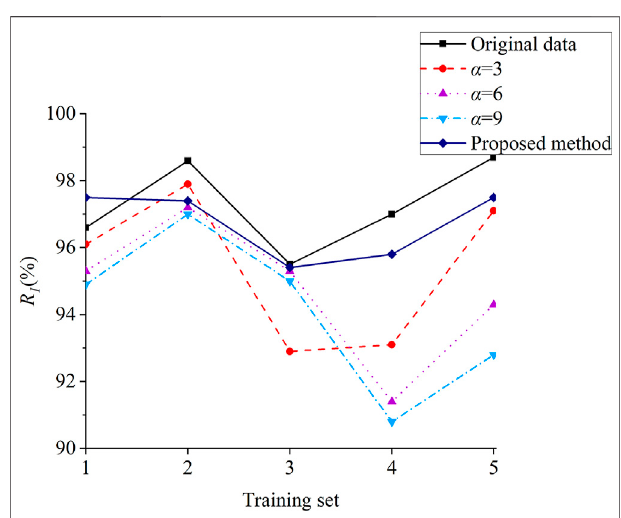
FIGURE 6 | Accuracy of test set stable samples.